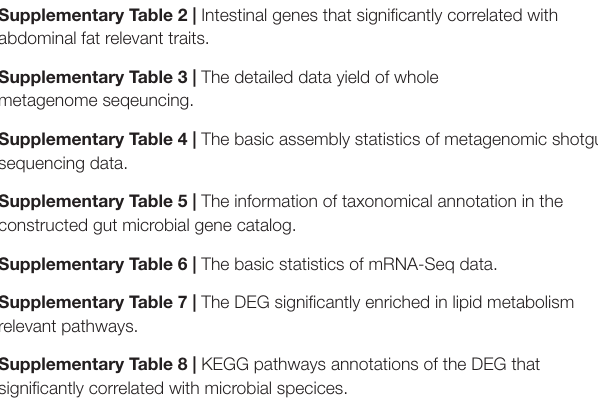
Supplementary Table 1 | Primers of validation qPCR experiment. Supplementary Table 2 | Intestinal genes that significantly correlated with abdominal fat relevant traits. Supplementary Table 3 | The detailed data yield of whole metagenome seqeuncing. Supplementary Table 4 | The basic assembly statistics of metagenomic shotgun sequencing data.